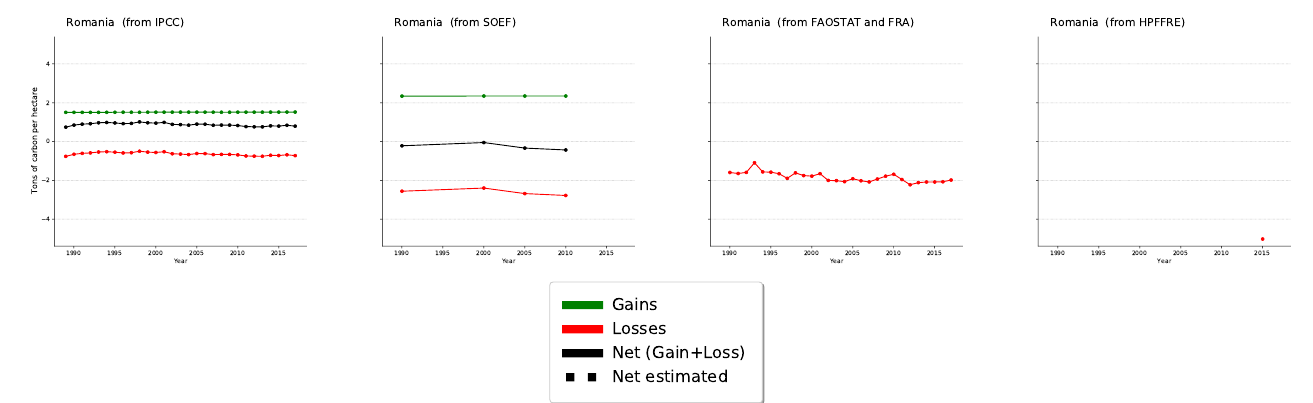
Figure 4. Comparison of the time series of forest dynamics for a selection of countries. All sources are expressed in the same unit (tonnes of